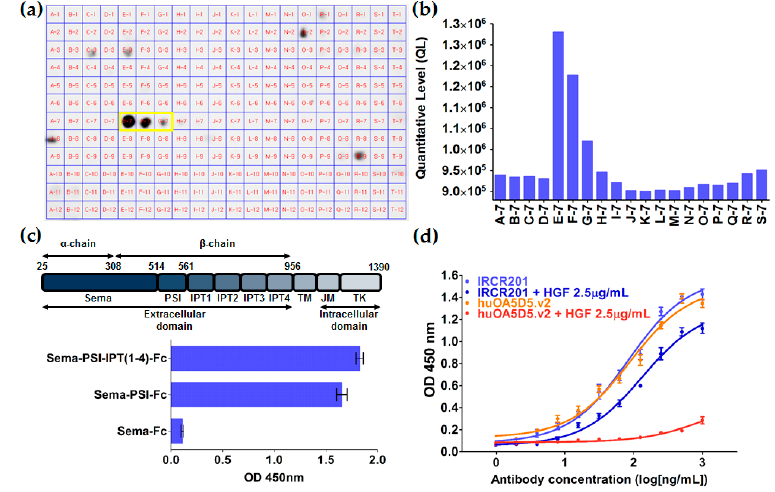
Figure 2. Epitope mapping of IRCR201. ( a , b ) The reactivity of IRCR201 against a panel of overlapping